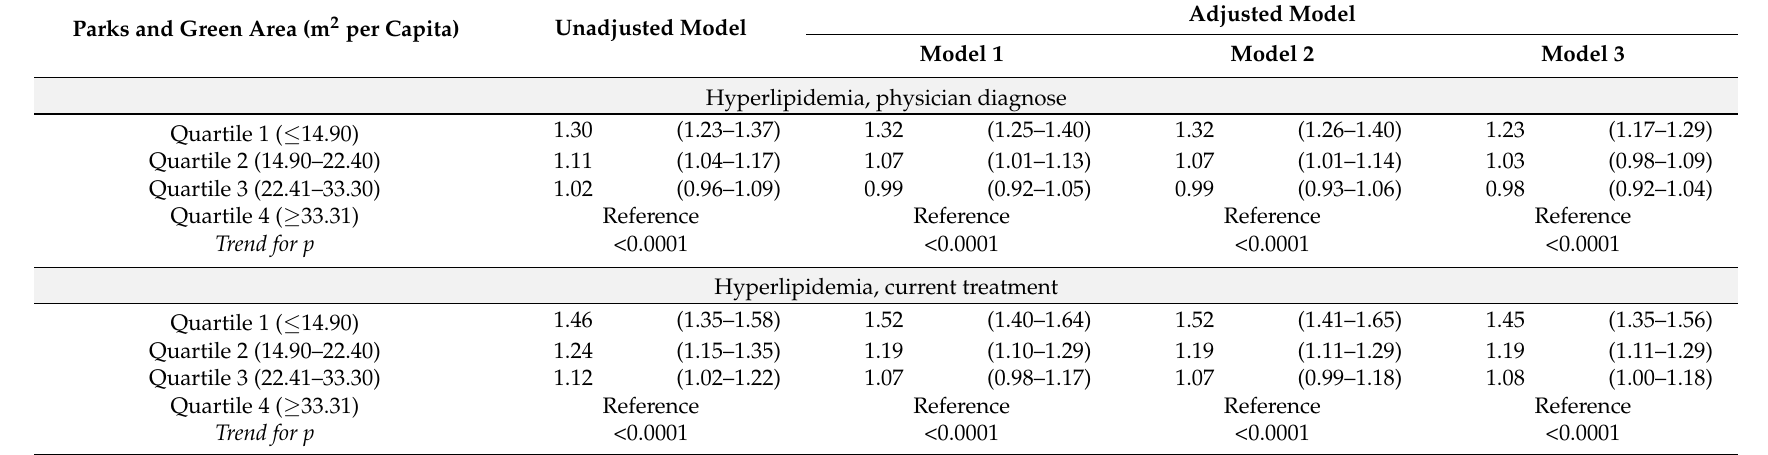
Table 2. Odds ratio (95% confidence interval) of hyperlipidemia against the quartiles of parks and green areas. Parks and Green Area (m 2 per